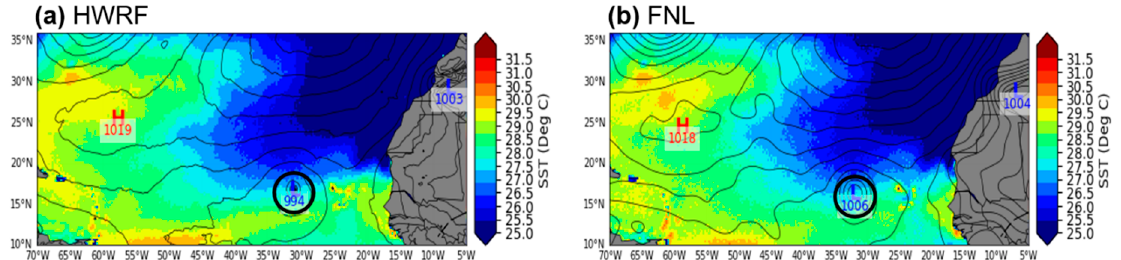
Figure 6. Sea surface temperatures (SSTs, shaded) and mean sea level pressure (MSLP, contours and centers) in the environment near Hurricane Irma from ( a ) 12 h into an HWRF forecast initialized at 1200 UTC on 30 August 2017 and ( b ) FNL valid at 0000 UTC on 31 August 2017. The center position of Irma is identified by a black circle. SST has units of °C, and MSLP has units of hPa.